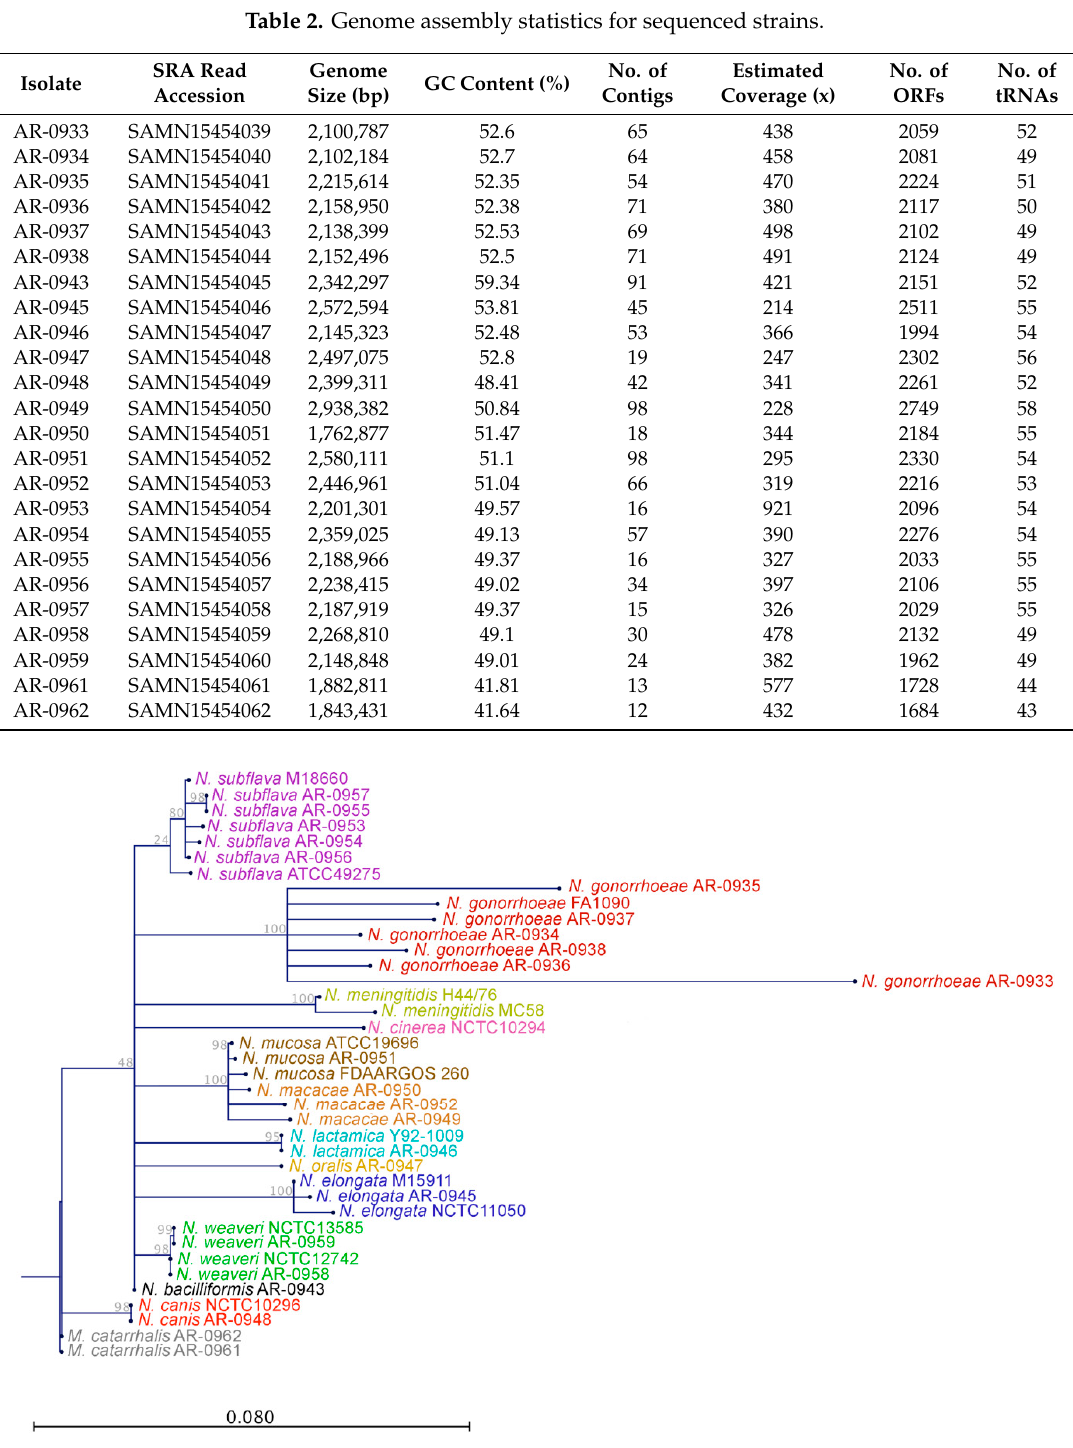
Figure 1. Maximum likelihood phylogenetic tree of 38 Neisseria isolates based on the 16S rRNA gene: species are coded by unique colors. The scale bar represents 0.08 substitutions per nucleotide site. Antibiotic Resistance (AR) Bank # 0961, one of the Moraxella catarrhalis in the Neisseria species MALDI-TOF verification panel, was used as an